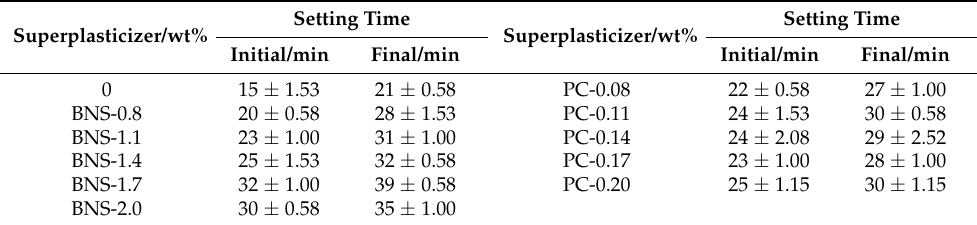
Table 3. Setting time of BNS and PC superplasticizers with different